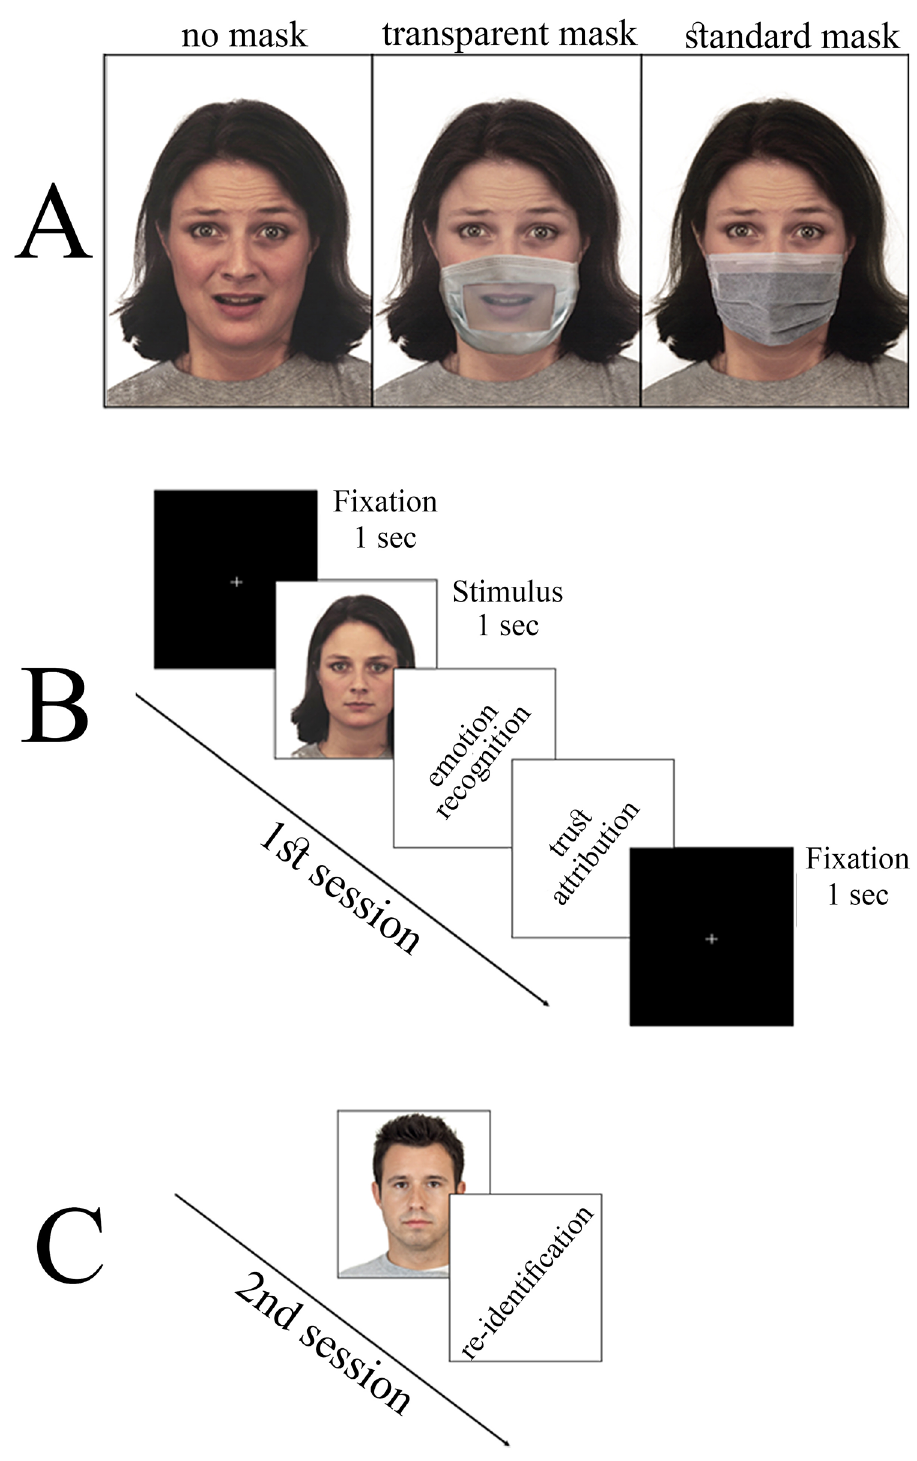
Figure 1. Experimental paradigm. ( A ). Stimuli consisted of faces from the Karolinska Directed Emotional Faces database (KDEF) and from a subset of the Chicago Face Database (CFD) validated for Italian subjects 26 , presented in unmasked fashion (NM, left panel), or masked with either transparent (TM, central panel) or standard (SM, right panel) medical facemasks. ( B ). In the first experimental session, participants were presented with KDEF and CFD stimuli shown in NM, TM or SM condition. After each presentation, they were required to indicate the posed emotion selecting between 4 options (Fear, Sadness, Happiness and Neutral) and, subsequently, to rate the perceived trustworthiness on a 6-point Likert scale. ( C ). In the second experimental session, participants were presented with pictures of unmasked faces from the CDF database. One third (4/12) of the presented stimuli was also presented in the first session in one of the three Conditions (SM, TM, NM). For each picture, participants were required to judge whether they have seen the face or